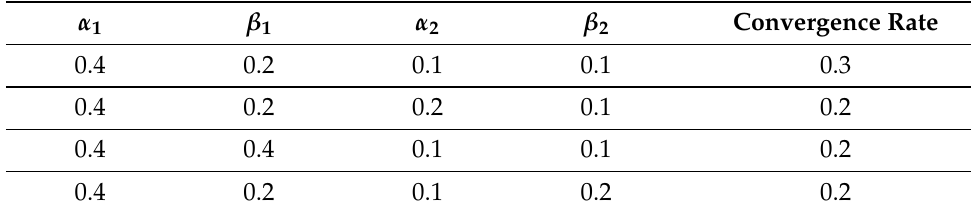
Table 1. Convergence rate for four cases of different